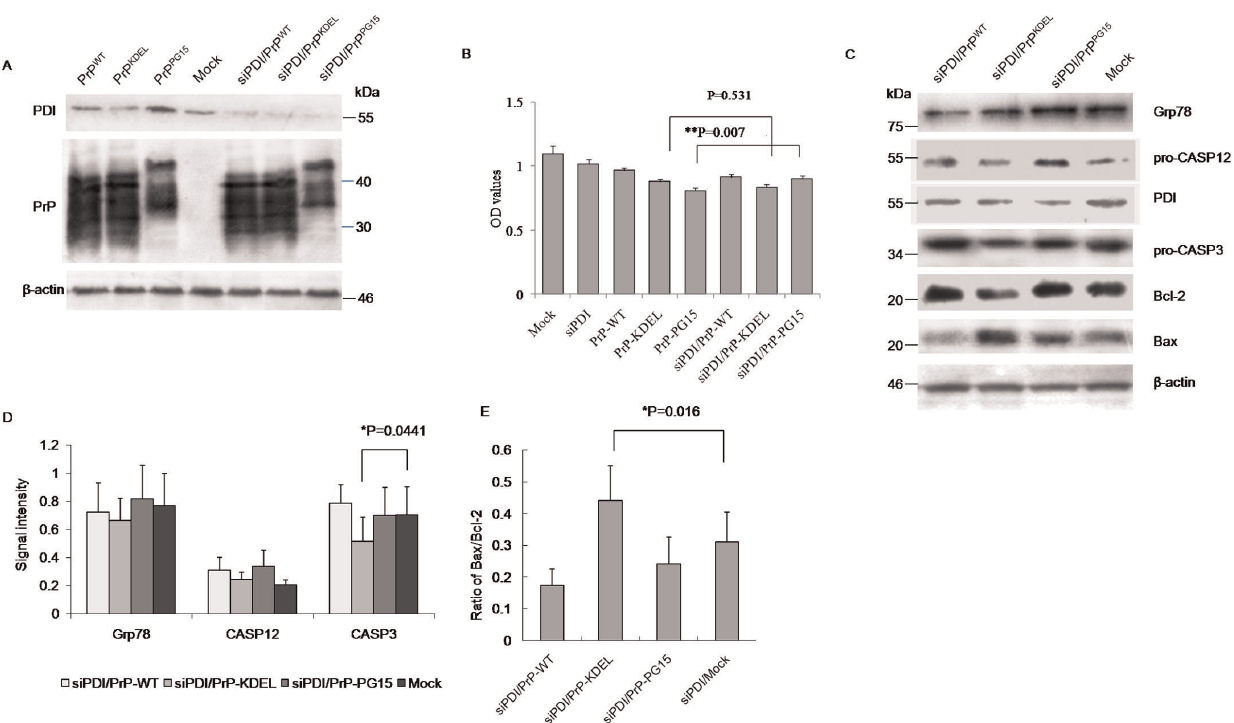
Figure 5. Influences of knockdown of endogenous PDI on PrP mutants-induced cytotoxicity and the alterations of relevant cellular factors. A. Evaluation of the influence down-regulating PDI on the expressions of various PrP constructs by Western blots. Cell lysates were separated in 15% SDS-PAGE and the specific immunolots for PDI and PrP were reacted with individual antibodies. B. Cell viabilities assayed by CCK- 8 kit. Each group is assigned to three repeating parallel units and measured with a spectrophotometer under 450 nm. The results are calculated from three independent tests and indicated as mean 6 SD. Statistical differences compared with controls are illustrated as **P , 0.001. C. Western blots. Cell lysates were separated in 15% SDS-PAGE and the specific immunolots for Grp78, pro-caspase12, PDI, pro-caspase3, Bcl-2 and Bax were detected with individual antibodies. D. Quantitative analysis of each gray numerical value of Grp78, pro-caspase12, pro-caspase3 vs that of individual b -actin. The results are calculated from three independent tests and presented as mean 6 SD. Statistical differences compared with controls are illustrated. E. The relative densities of Bcl-2 and Bax specific bands normalized to b -actin are presented as ratio of Bax/Bcl-2. Statistical differences compared with controls are illustrated.